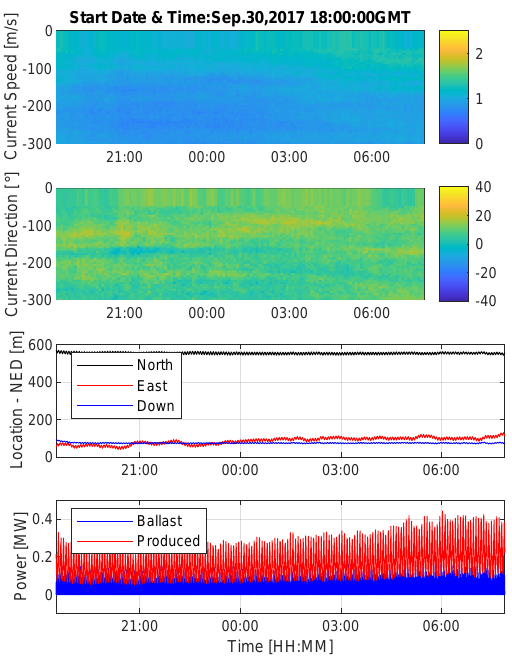
Fig. 10. Hurricane condition (September 25, 2017): time histories of the OCT’s states, i.e., Euler angle, location-NED, and power. Moreover, performance results were presented for both normal and hurricane conditions where the operating depths remained within 75 m ± 35 m by using a PI controller. Future work will focus on flight and gen- erator control for the buoyancy controlled OCT and the development of a hierarchical control architecture such as a spatiotemporal optimization to maximize harnessed power from the overall OCT system. Control methodologies should also be developed to integrate the harnessed power from the buoyancy controlled OCT into power grids using energy storage and power